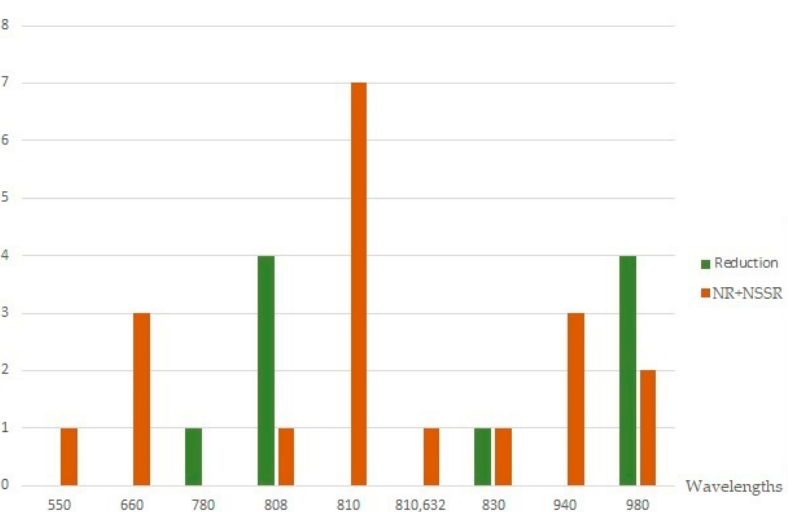
Figure 3. Histograms showing the swelling outcome according to the wavelengths of the included studies. Legend: NR, no reduction, NSSR, no statistically significant results.